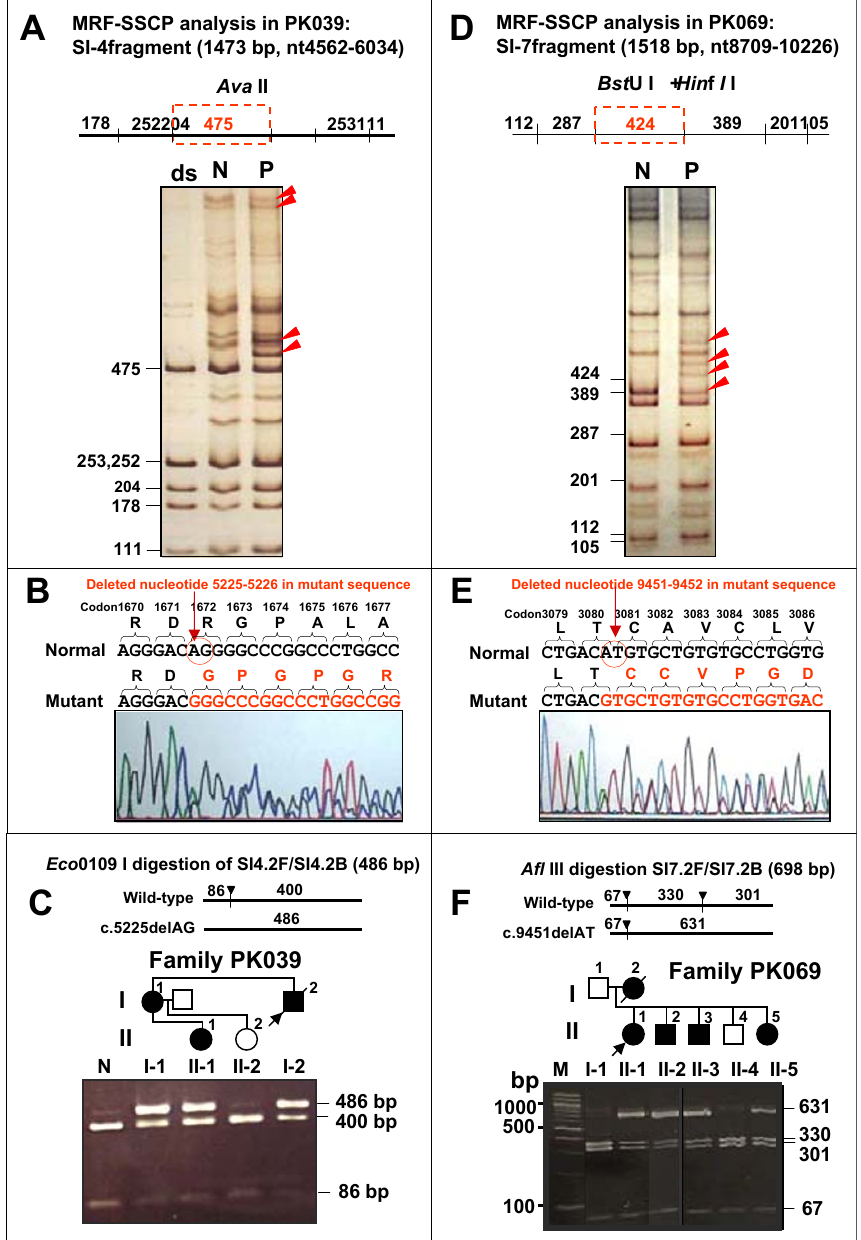
Figure 4 Frameshift deletions found in families PK039 (A-C) and PK069 (D-F). A, D. MRF-SSCP analyses of SI-4 and SI- 7 fragments from the patients of families PK039 and PK069, respectively. The maps of restriction fragments obtained from digestions of PCR fragments by sets of endonucleases in two families are shown (upper). The MRF-SSCP analy- ses (lower) of the patients (P) from both families show mobility shifts of single-stranded DNAs (pointed) when compared with those of normal controls (N). These fragments are located in the dotted box of the upper map. B, E. Sequencing analyses of PKD1 -cDNA from the two patients. The sequencing profiles of both families show different types of two nucleotide deletions (c. 5225_5226delAG and c.9451_9452delAT), resulting in frameshift translation, as compared with the normal sequence. C, F. Direct detection of the two deletions (g.29124_29125delAG and g.39376_39377delAT) in mem- bers of the families PK039 and PK069, respectively. The di-nucleotide deletions in PKD1 genomic-DNA in members of both families were detected by restriction analyses. The two mutations abolish recognition sites of Eco 0109 I and Afl III, respec- tively. The presence of larger fragment in each case indicates the existence of